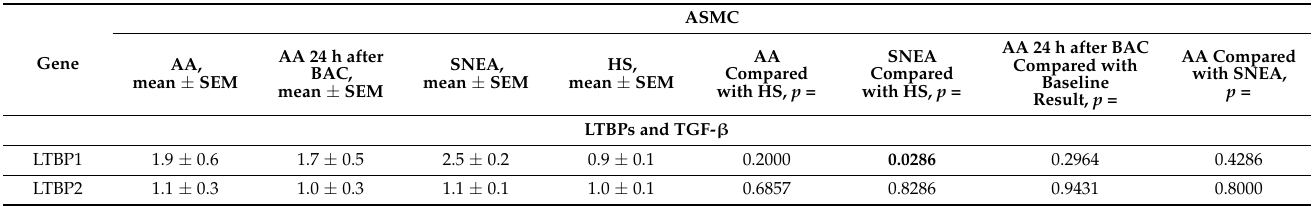
Table A5. p values of evaluated gene expression in Figures 5 and